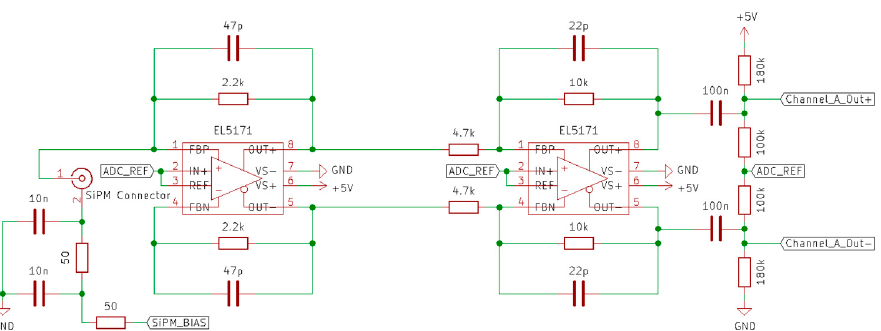
Figure 2. Two stage EL5171 op-amp based ampli fi er. The fi rst stage is a transimpedance ampli fi er with di ff erential output, and the second phase is an inverting ampli fi er, both with a set gain.